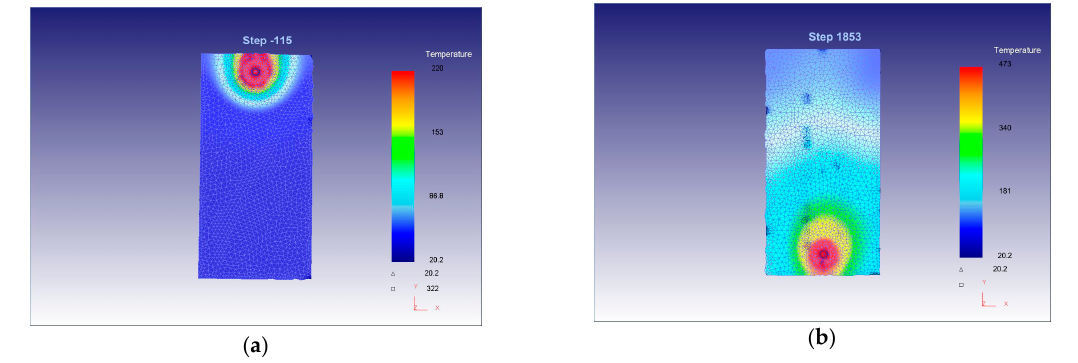
Figure 12. Distribution of temperature fields: ( a ) At the end of the first phase of the FSW process; ( b ) at the end of the second phase of the FSW process.